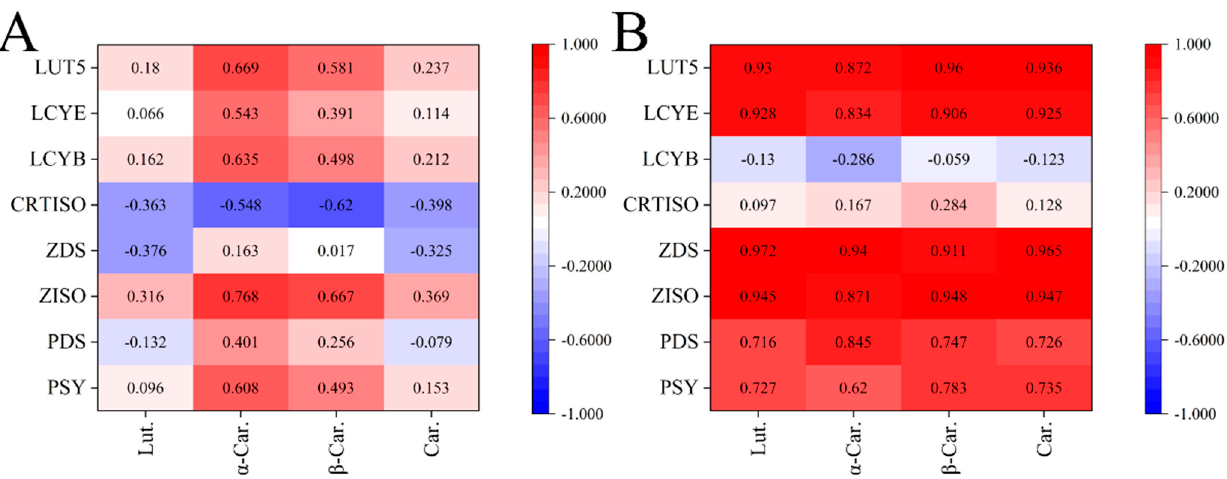
Figure 4. Pearson correlations between carotenoids ( A , B ) composition contents and their gene expression levels. ( A ) The correlations of honey pomelo. ( B ) The correlations of golden pomelo. “Lut.” stands for lutein; “ α -Car.” stands for α -carotene; “ β -Car.” stands for β -carotene; “Car.” stands for total carotenoids.